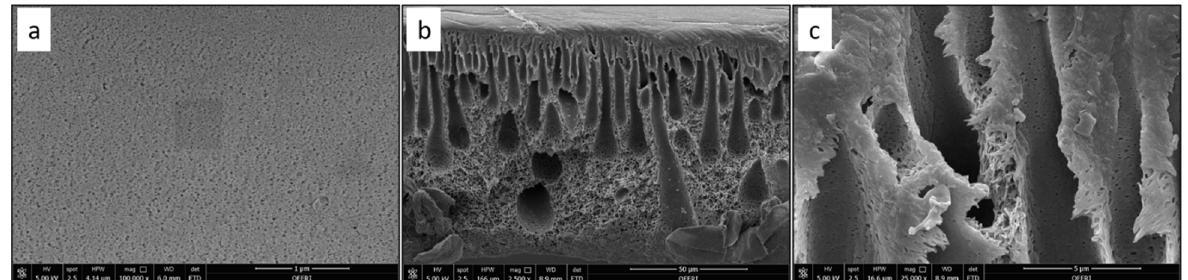
Figure 5. SEM images for PSF/0.1 wt.% CNF (M2) sample: ( a ) top surface, ( b ) cross-section, ( c ) enlarged top cross-section.